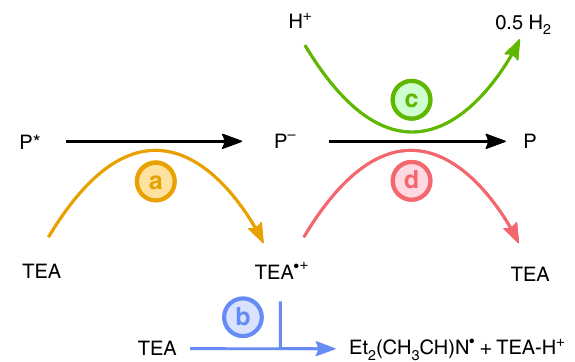
Figure 15). The signal amplitude at 630 nm increases up to a